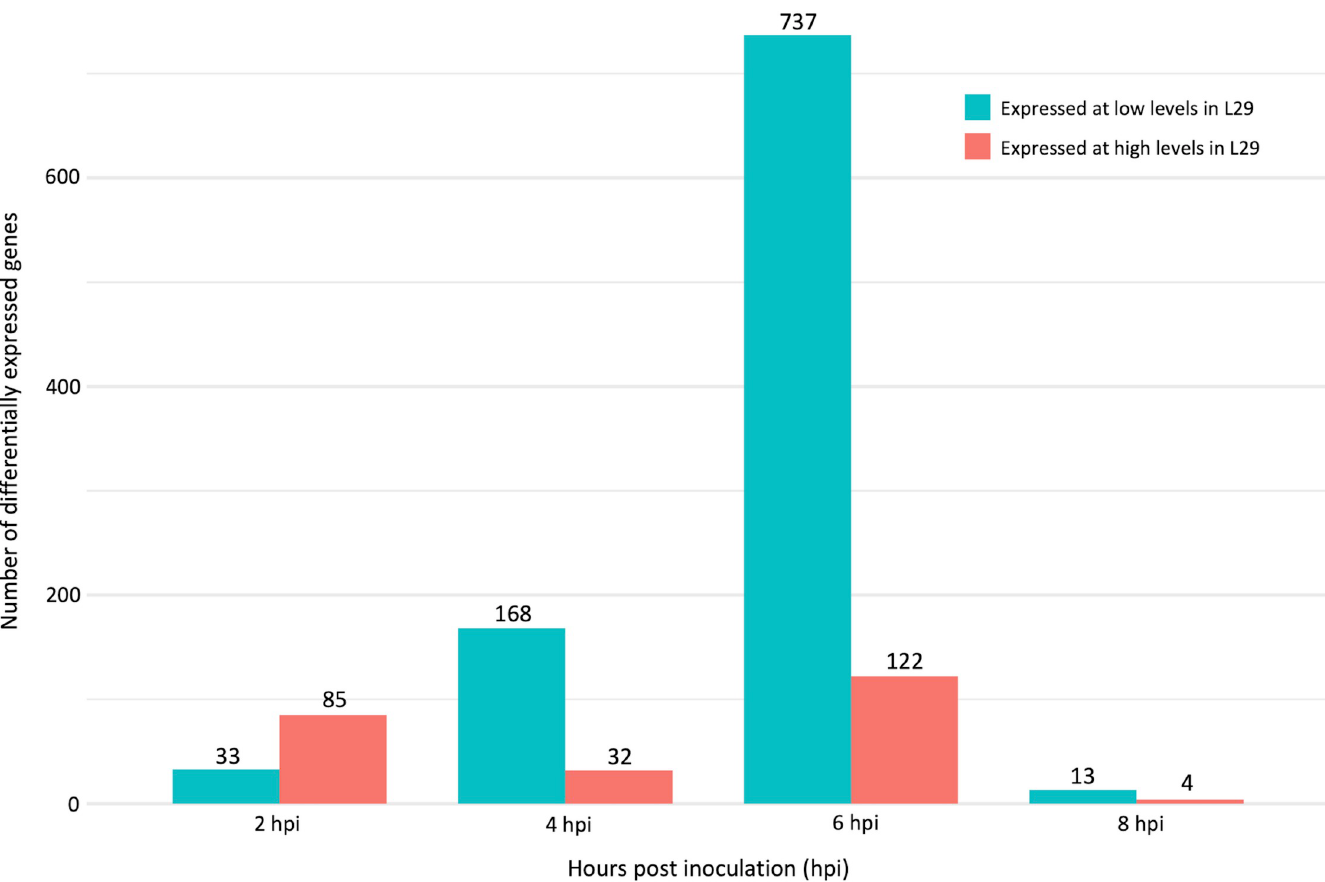
Fig 1. Number of differentially expressed genes between soybean cultivars L29 and Williams82 at 2, 4, 6, and 8 hours post inoculation with Soybean mosaic virus strain G7. DEGs were defined as those with FDR adjusted p-value < 0.05, log 2 fold change > |1.0|, and base mean > 10. High expression or low expression in L29 means the expression of DEG was either higher or lower in L29 as compared to Williams82, respectively. A total of 1128 DEGs were identified between L29 and Williams82 at 2, 4, 6 and 8 hpi. DEGs at 0 hpi were minimal and excluded, being considered effects of differences in genetic backgrounds of the two cultivars and not infection